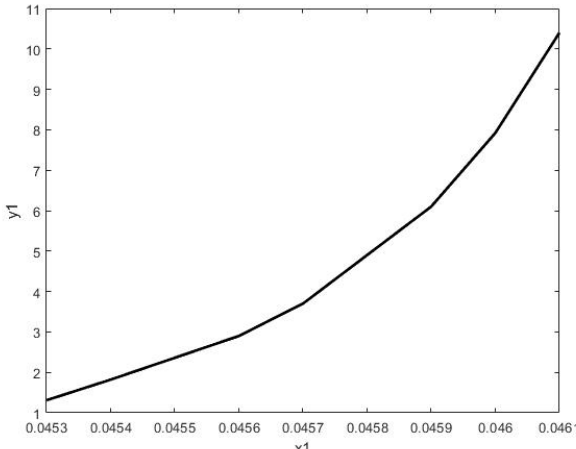
Figure 4. Torque(y 1 ) vs. rotor outer radius (x 1 ). Pareto frontier is obtained using the Monte Carlo method by calculating the criteria values in a regular network with 600 × 600 × 600 × 600 × 5 node points and selecting those points that are not competing. Of the 648 billion points, 3371 Pareto frontier points were selected, a 3D Mesh plot (Figure 5). The calculation takes about 15 h for the Intel i9 10900K 5.1 GHz processor.